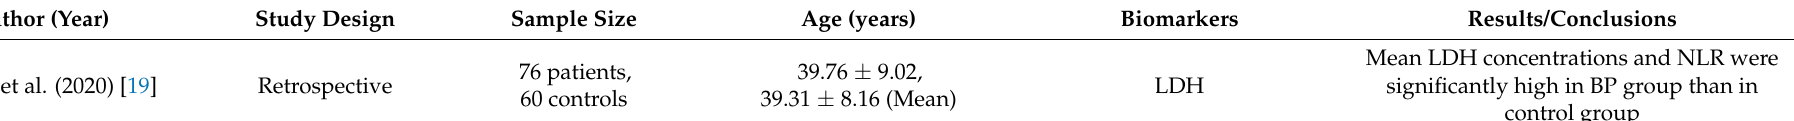
Table 2. Summary of prognostic biomarkers for acute peripheral facial palsy (Metabolic